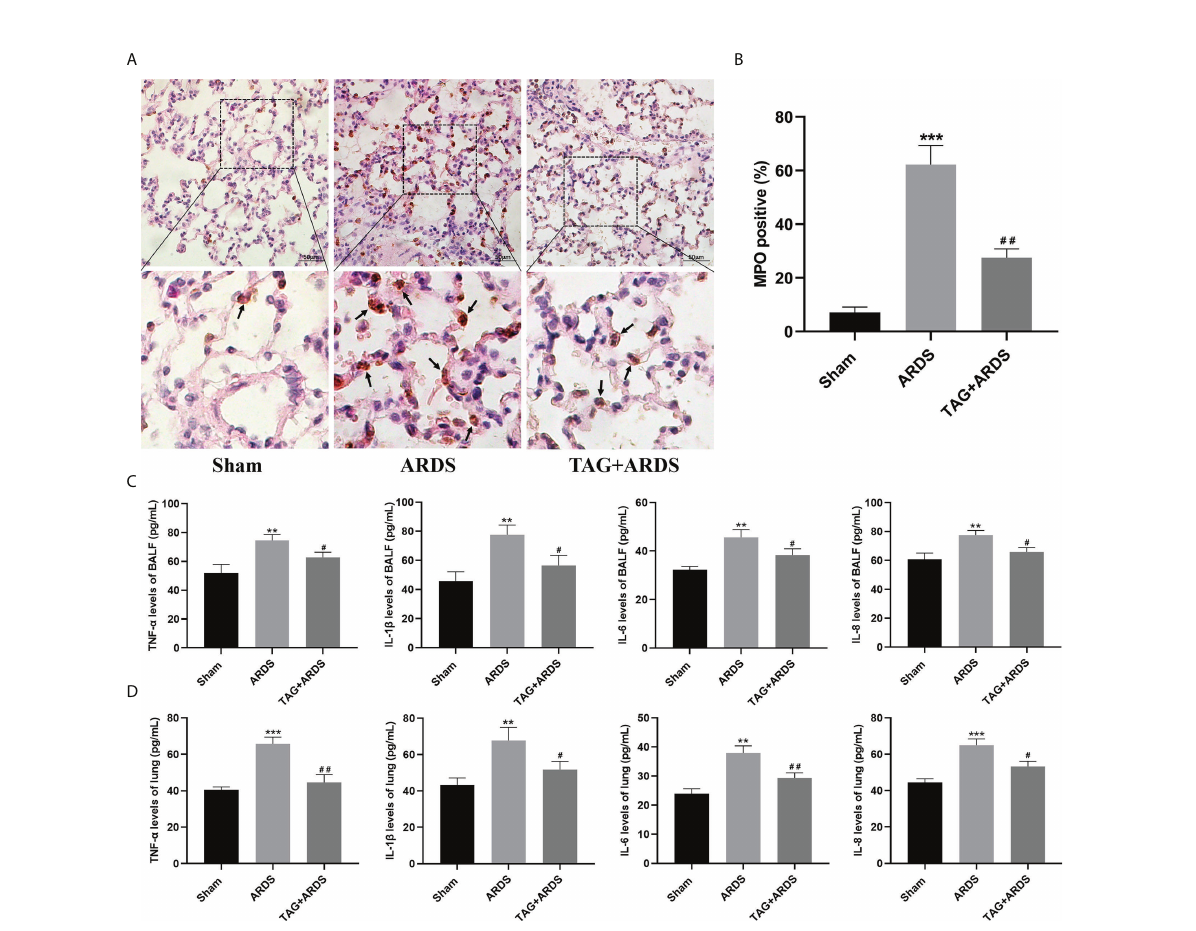
FIGURE 3 Effects of TAG on ARDS-induced in fl ammation. (A, B) Representative images of MPO-positive lung cells and their quanti fi cation in experimental animal groups: Sham, ARDS, and TAG + ARDS. Arrows represent neutrophil in fi ltrations (scale bar = 50 m m). (C, D) Levels of TNF- a , IL-1 b , IL-6, and IL-8 in BALF and lung tissues assessed by ELISA. Data are presented as mean ± SD. ** p < 0.01, *** p < 0.001, compared with the Sham group; # p < 0.05, ## p < 0.01, compared with the ARDS group. MPO, myeloperoxidase; TAG, D-tagatose; ARDS, acute respiratory distress syndrome; IHC,